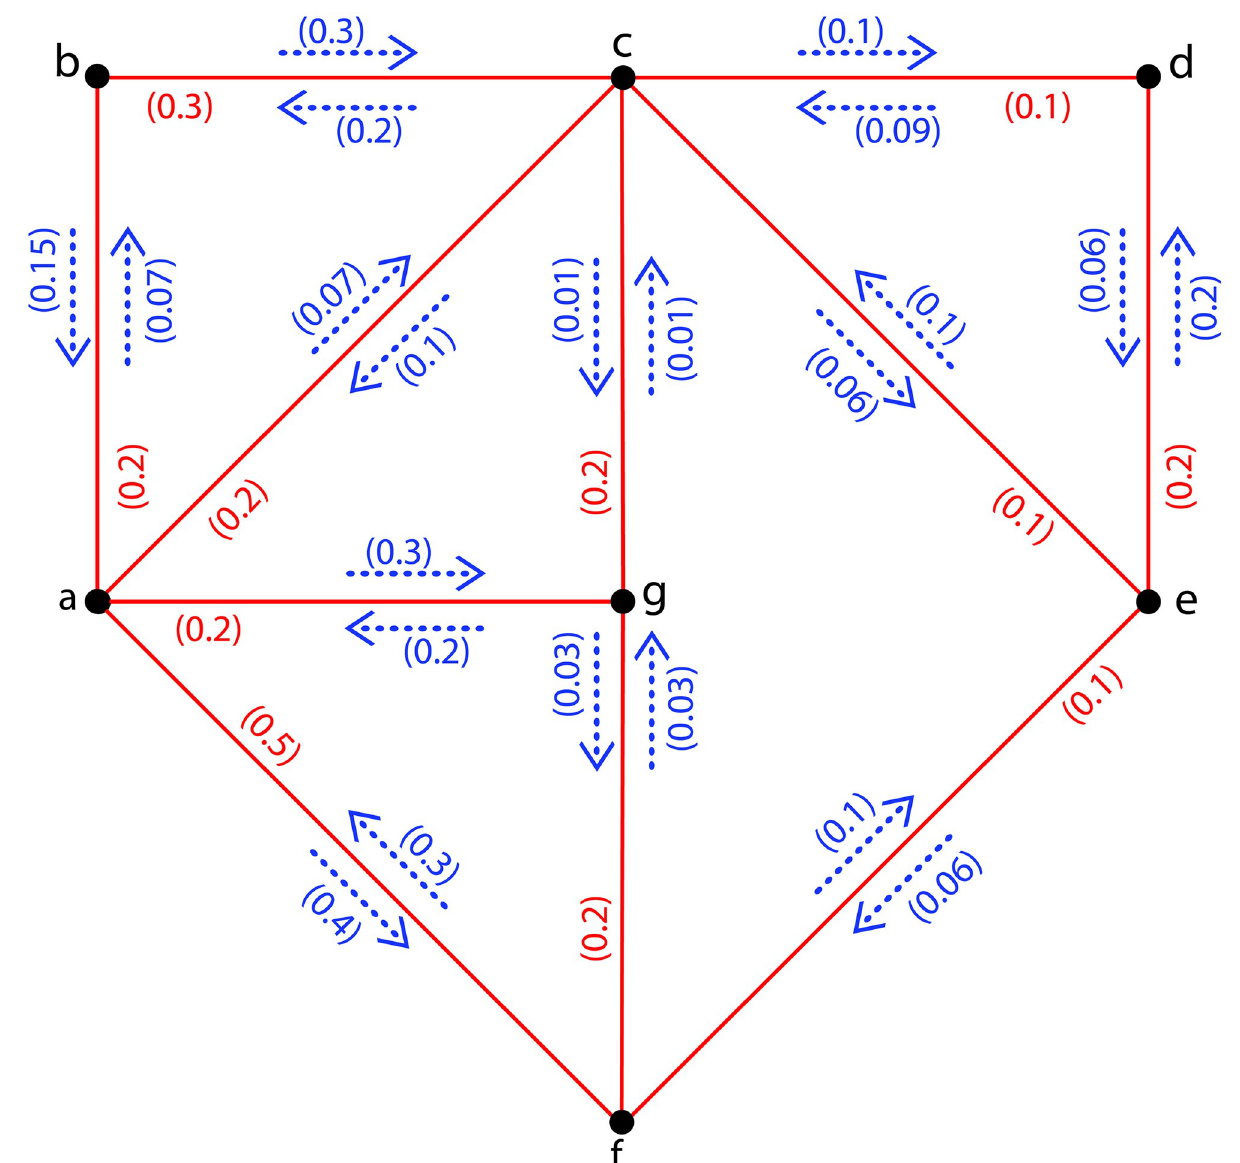
Fig 5. A FIG with O I =